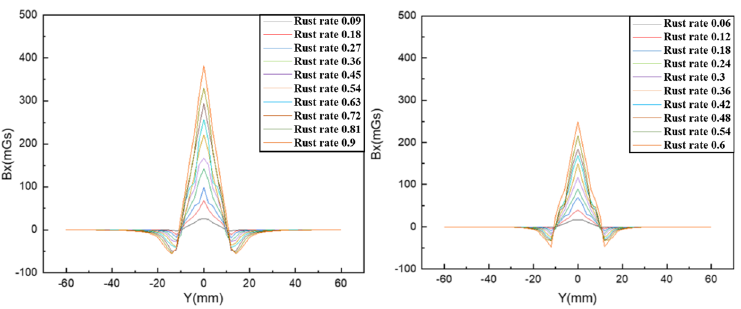
Fig. 15 Simulation calculation of Bx component of flux leakage signal along Y- axis under different rust